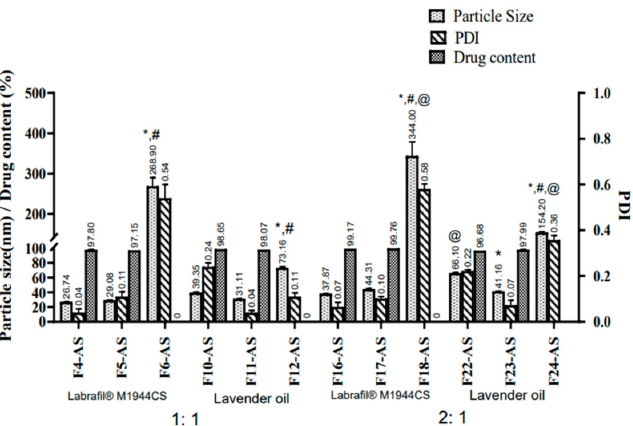
Figure 3. The physical characterization of ASP-loaded LNCs. All values are presented as the mean ± SD ( n = 3). * Significant difference in comparison to the formulation containing Kolliphor ® HS with the same oil type and ratio. # Significant difference in comparison to the formulation containing Kolliphor ® EL with the same oil type and ratio. @ Significant difference in comparison to the formulation with an oil:surfactant ratio of 1:1 with the same oil and surfactant